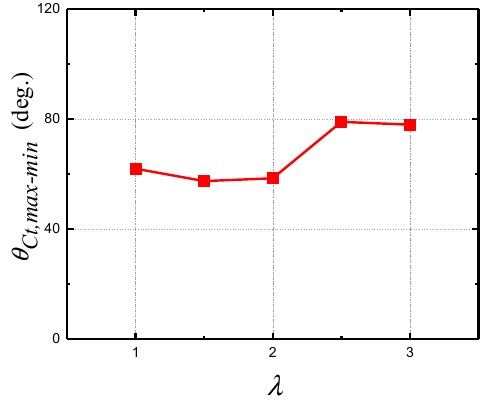
Figure 20. θ ct.max-mix of a blade with λ .